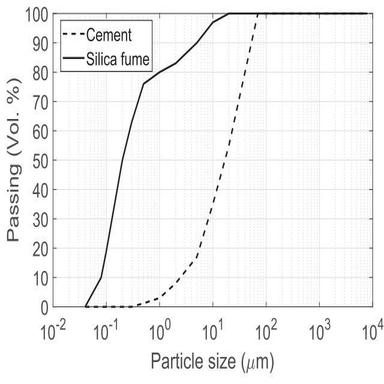
Particle size distributions of cement and silica fume.